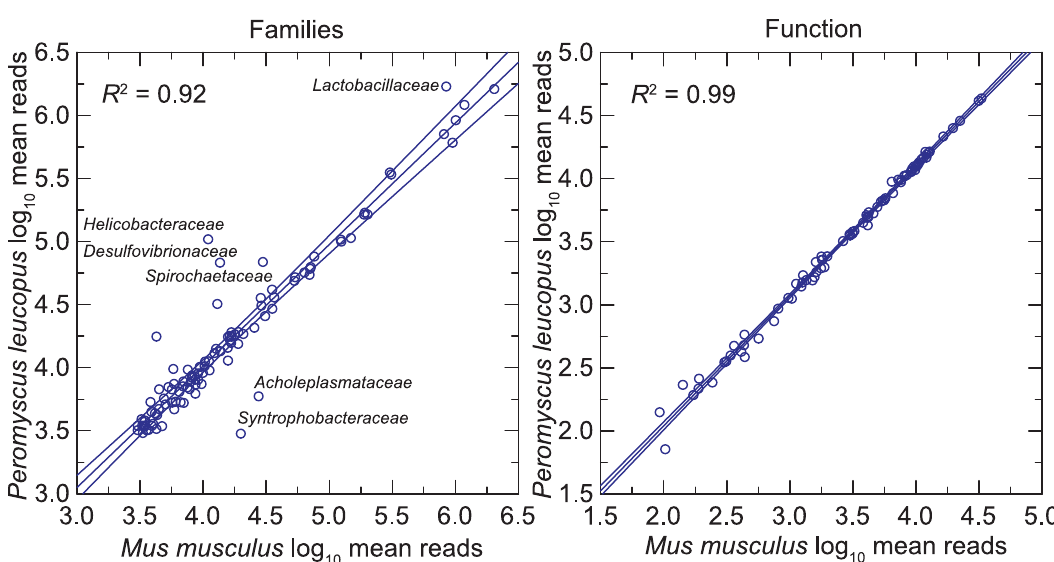
Fig 7. Scatter plots of log-transformed normalized reads of the gut metagenomes of 20 P . leucopus on the gut metagenomes of 20 M . musculus by bacterial families (left panel) or by function at the pathway level (right panel). The linear regression lines, their 95% confidence intervals, and coefficients of determination ( R 2 ) are shown. Selected families that are comparatively more or less prevalent in P . leucopus are